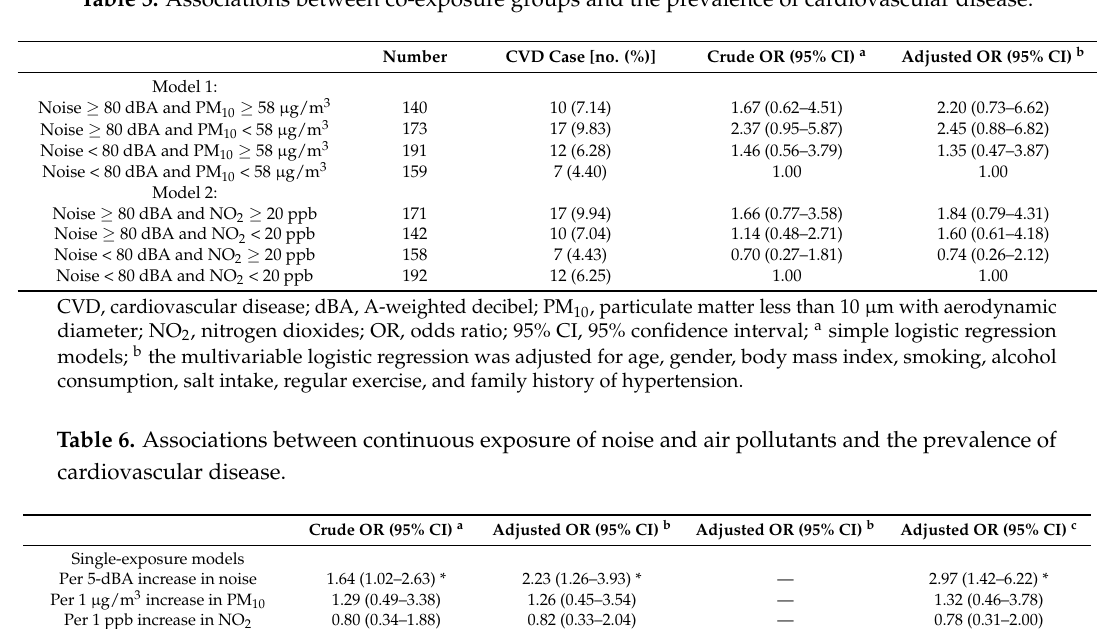
Table 5. Associations between co-exposure groups and the prevalence of cardiovascular disease.